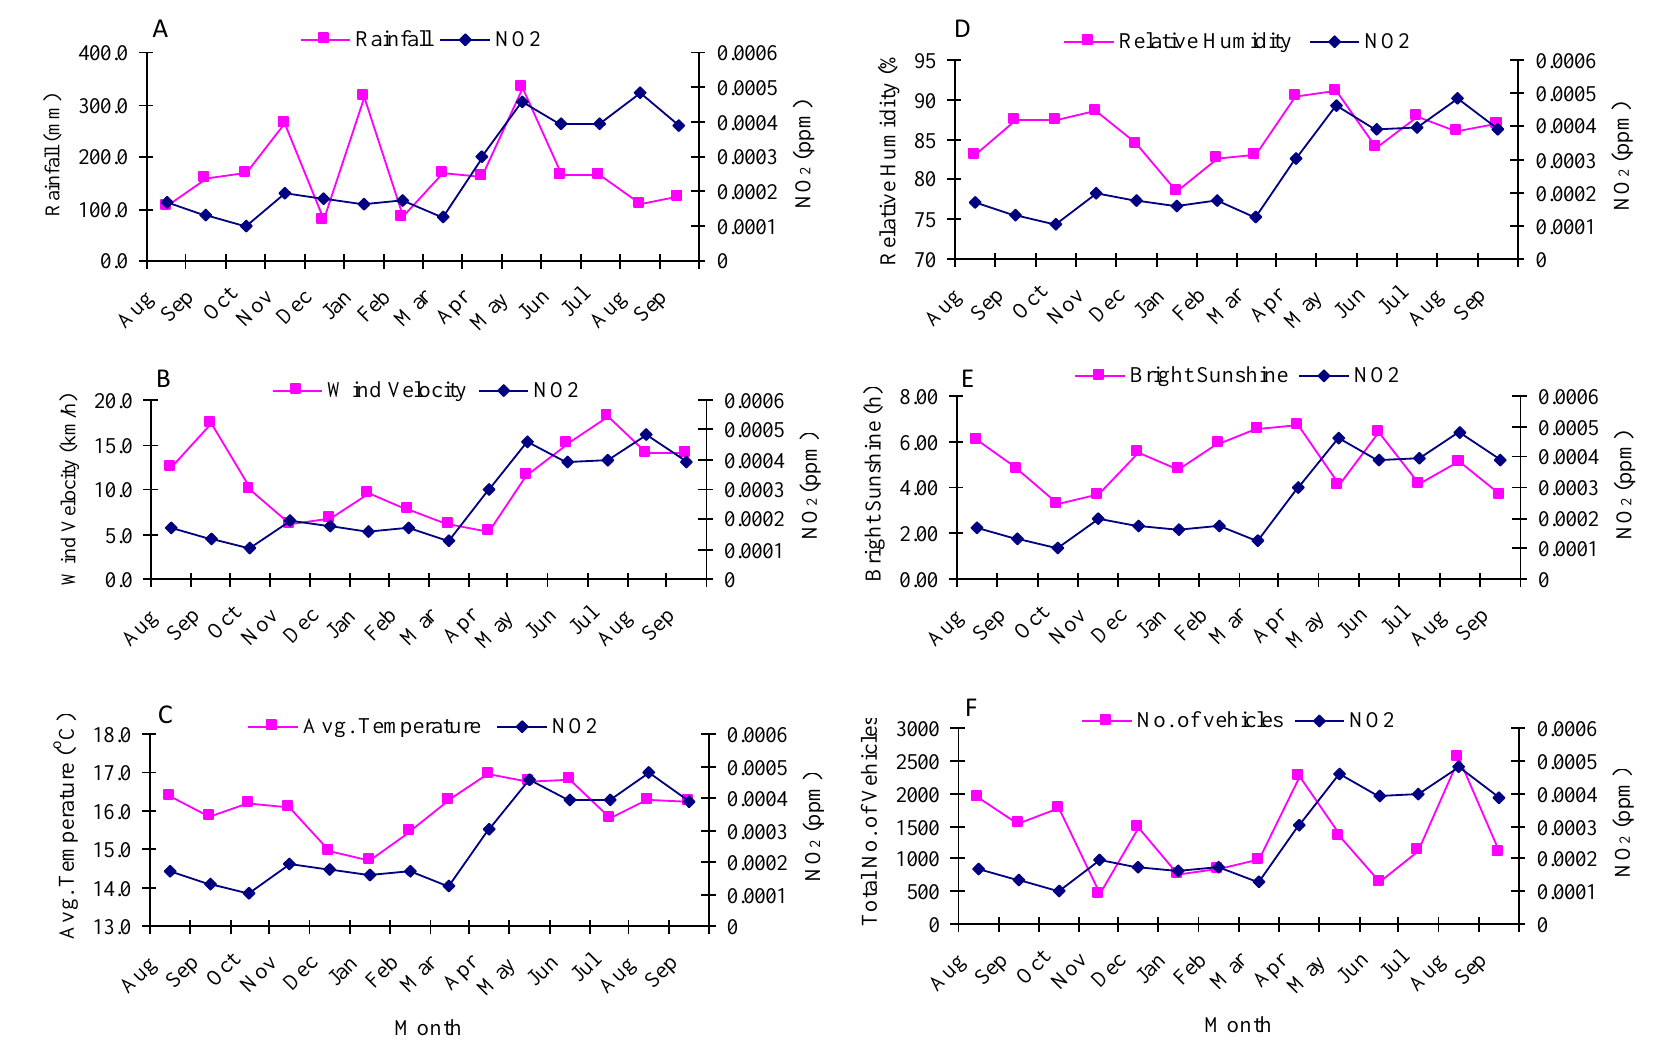
Figure 4 : Variation of NO 2 with rainfall (A), wind velocity (B), average temperature (C), relative humidity (D), bright sunshine (E) and total number of visited vehicles (F) in